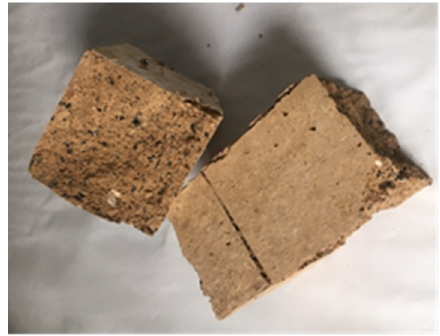
Figure 6. Appearance of test specimens after breaking.